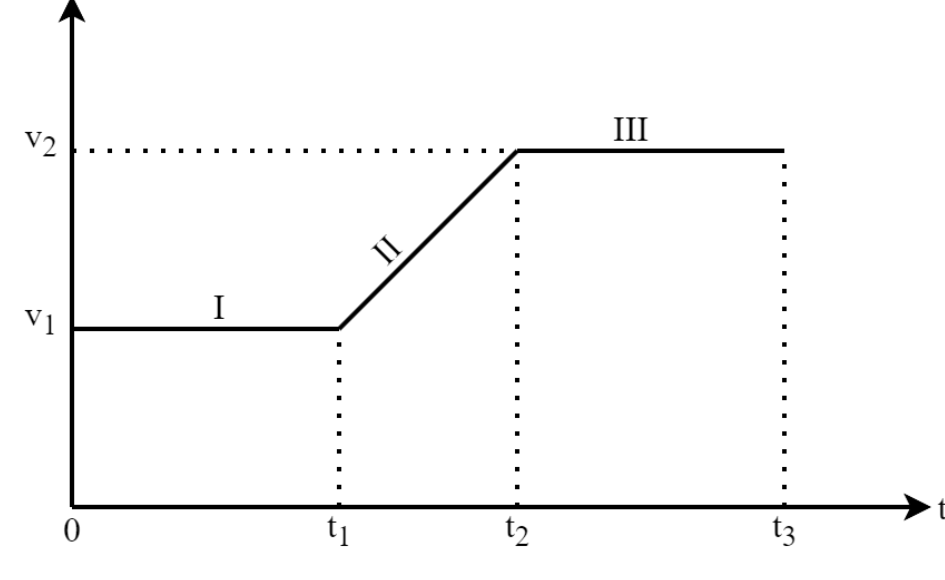
Figure 1. Cruise and accelerate combination